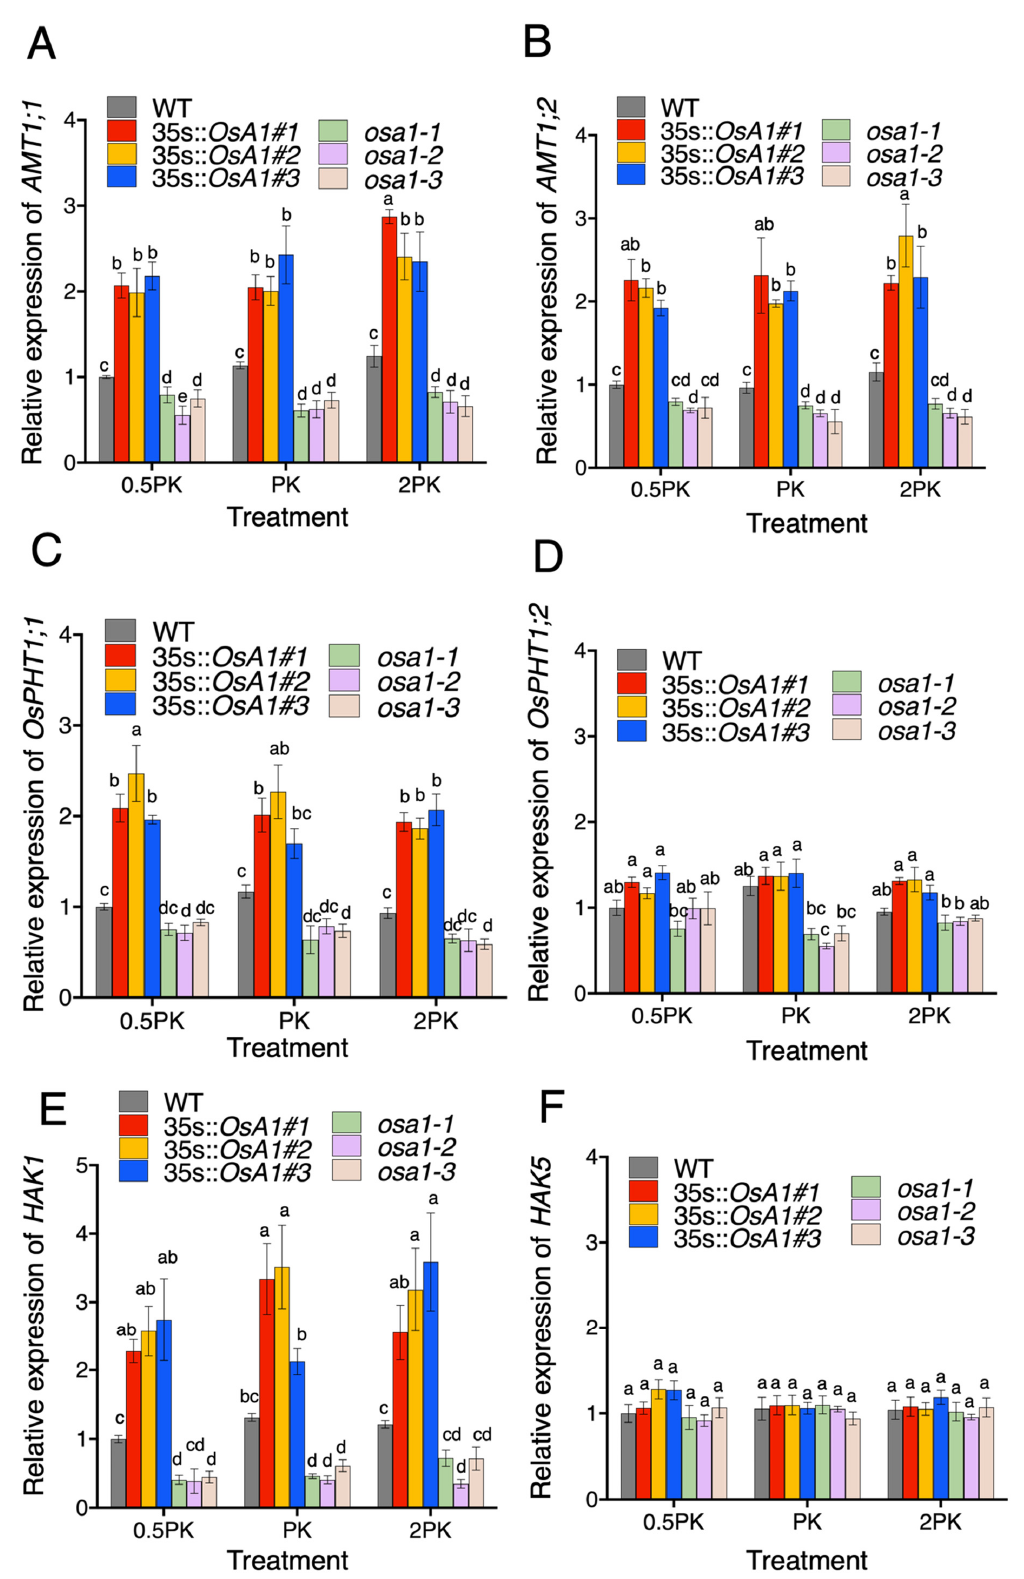
Figure 4. Relative expression level of N, P, and K transporter genes in roots of WT, OSA1 -oxs, and osa1 mutants. Four-week-old rice plants were cultured in IRRI nutrient solution containing 2.0 mM NH 4